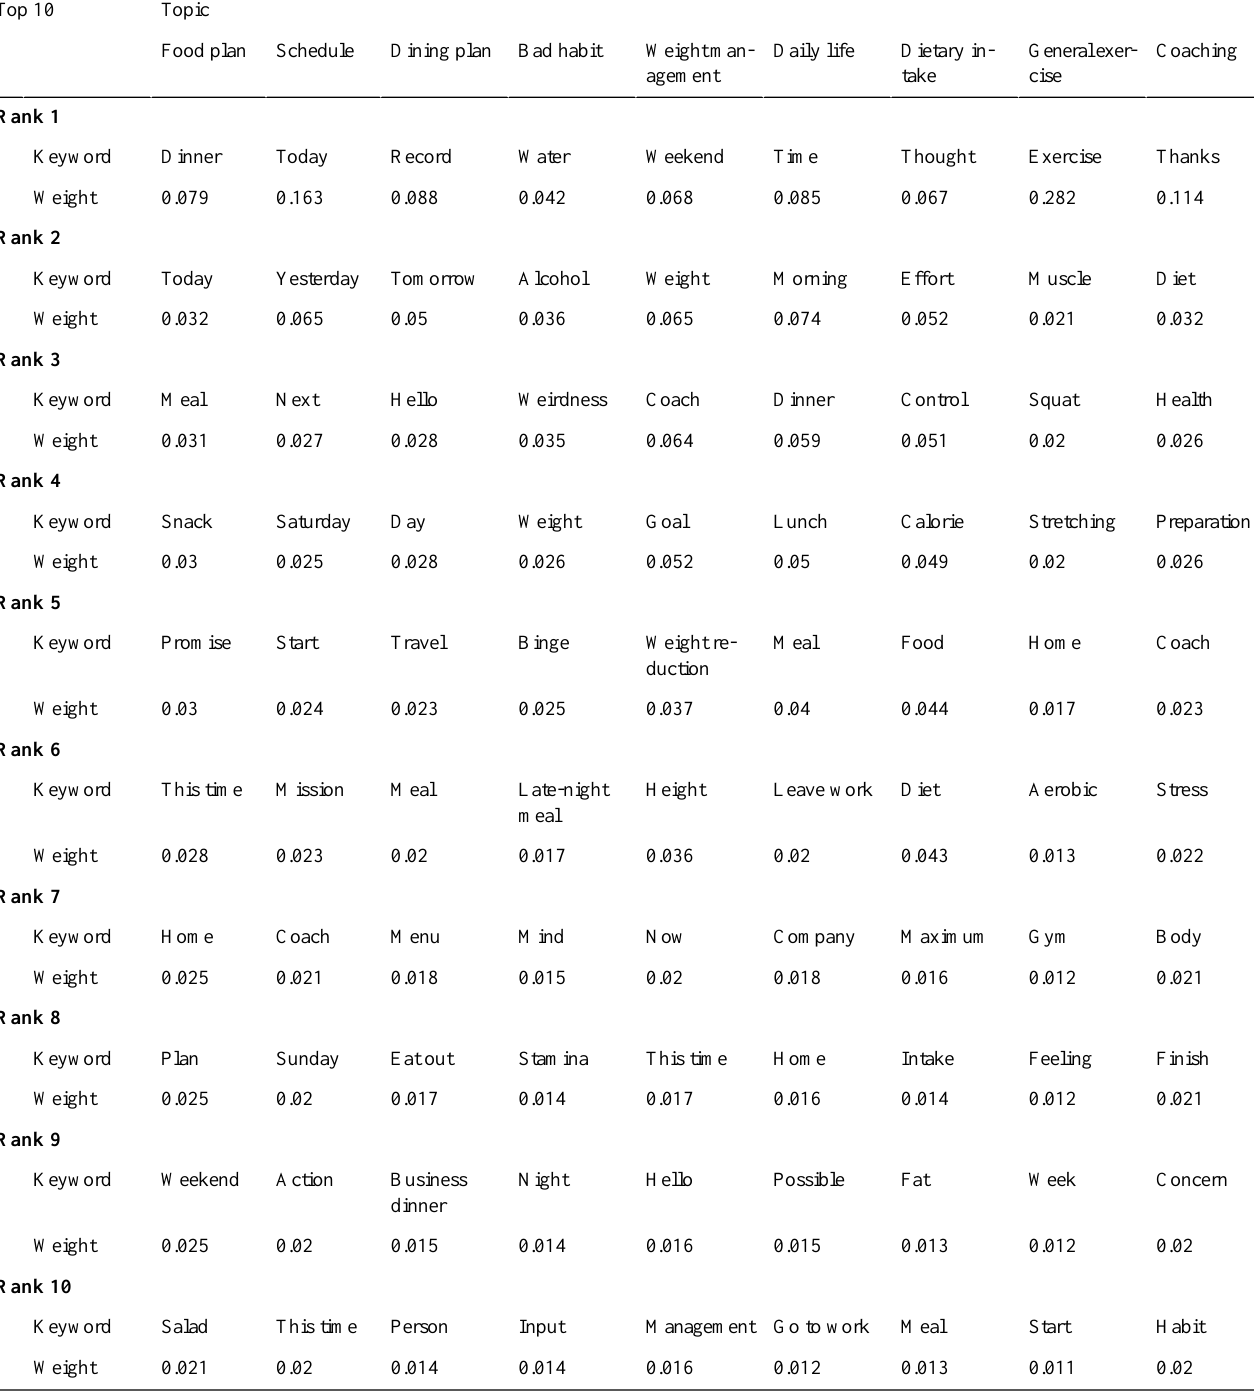
Table 2. Topic modeling results using a combination of the top 10 keywords and weight. TopicTop